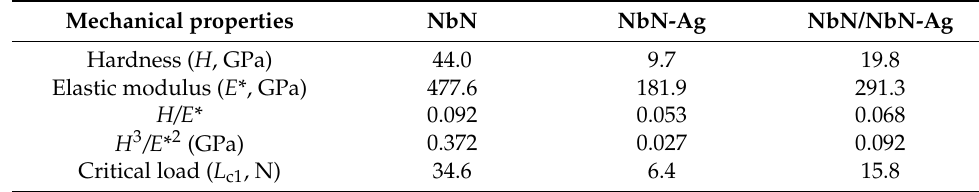
6 of 14 Figure 3. HRTEM cross-sectional micrographs and the corresponding SAED patterns of the films: ( a , d ) NbN; ( b , e ) NbN-Ag; ( c , f ) NbN/NbN-Ag. Table 2 summarizes the hardness ( H ), reduced Young’s modulus ( E *), H / E *, H 3 / E * 2 and critical load ( L c1 , the load corresponding to first chipping) of the studied films. The H and E * of NbN film are 44.0 and 477.6 GPa, which are obviously higher than the NbN film deposited by magnetron sputtering technique recently [24], while the correspond- ing values of NbN-Ag film are 9.7 and 181.9 GPa, respectively. The NbN-Ag film has